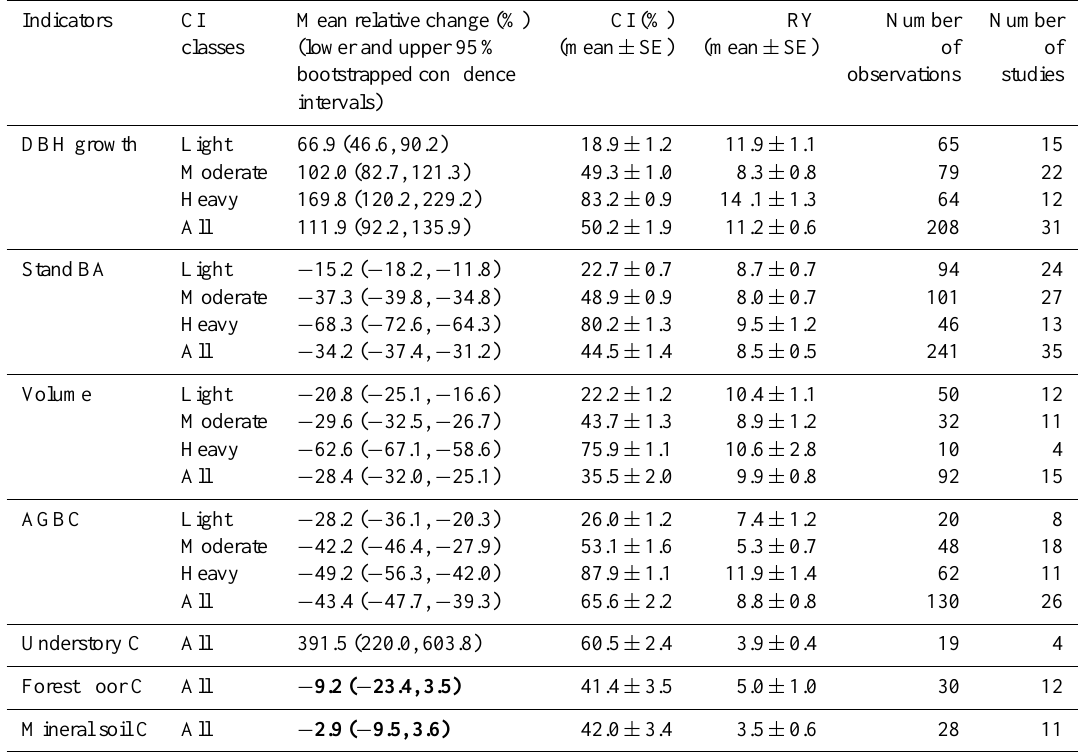
Table 1. Mean values of the relative changes (%) for the seven variables related to forest structure and carbon (C) storage, grouped by cutting intensity classes if